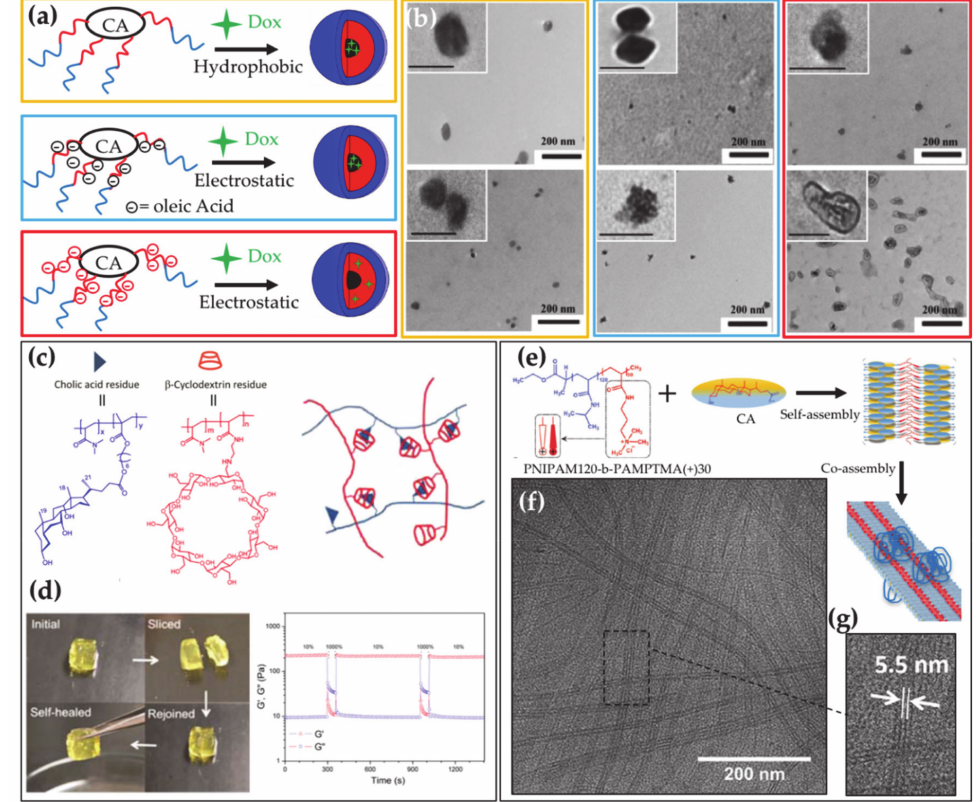
Figure 4. ( a ) Star-shaped block copolymers are able to load the drug Doxorubicin (Dox) through hydrophobic interaction (yellow box) or electrostatic interaction with (blue frame) or without (red frame) oleic acid (OA) as cosurfactant. ( b ) TEM micrographs of the star-polymer micelles